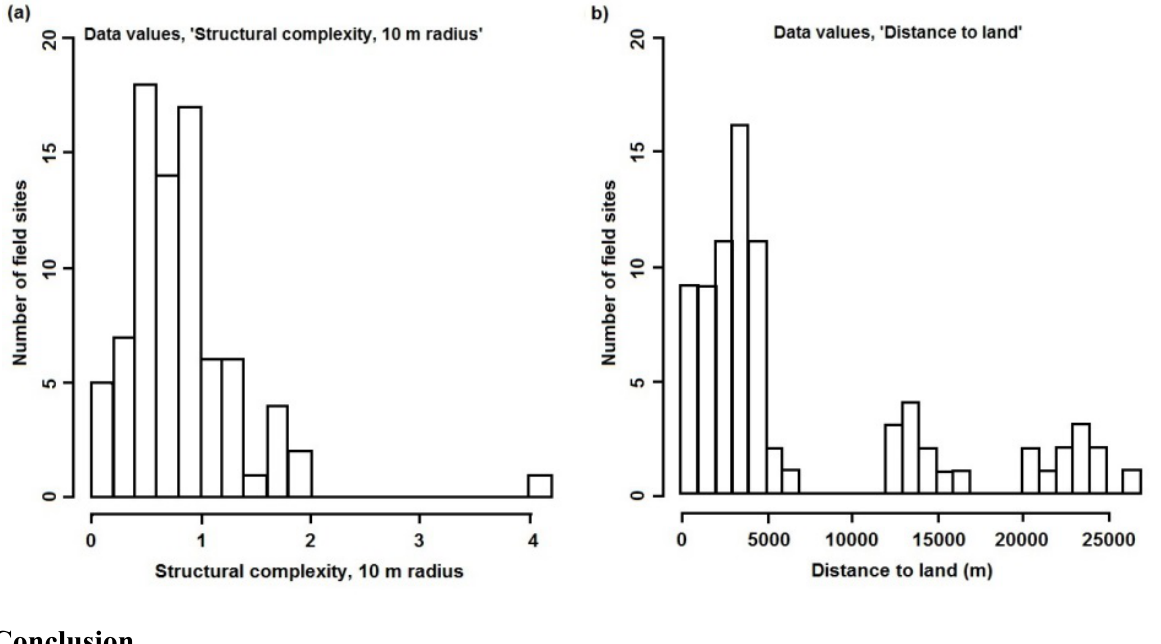
Figure 6. Histograms showing the distribution of values for ( a ) “structural complexity, 10 m radius”, and ( b ) “distance to land” at the field